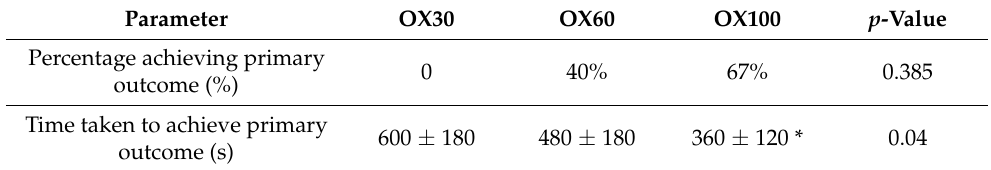
Table 2. Primary outcome: combined HR of ≥ 100 bpm and SpO 2 ≥ 80% by 5